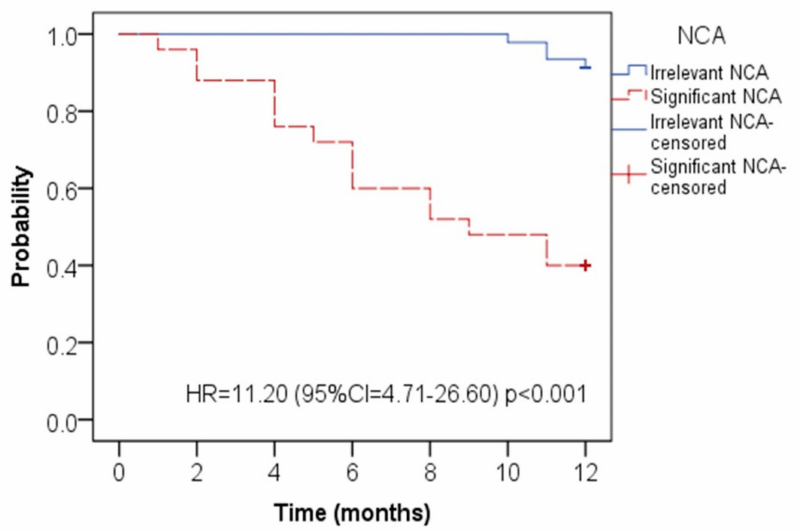
Figure 5. Kaplan-Meier curve for death events for the patients with clinically significant NCA (red line) and irrelevant NCA (blue line). (NCA: non-cardiac